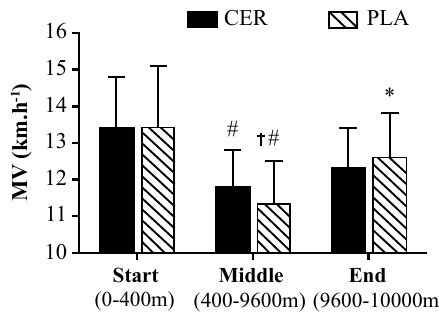
Figure 1. MV during the different phases adopted by the participants of the present study. *P < 0.05 vs the middle phase (400-9600 m) for the same condition; #P < 0.05 vs the start phase (0-400 m) for the same condition; †P < 0.05 comparing the conditions for the middle phase (400-9600